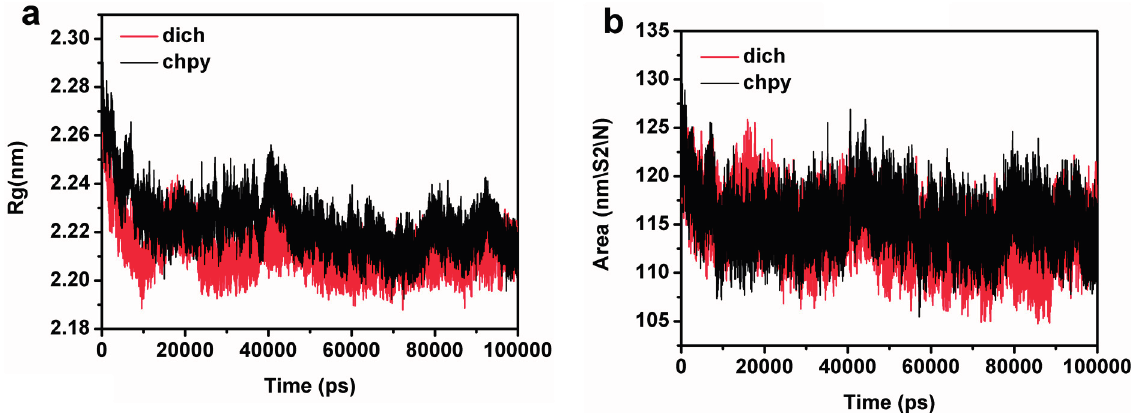
Figure 8. ( a ) Radius of gyration (Rg) for the chlorpyrifosmethyl oxon (black) and dichlorvos (red) bound to APH; and ( b ) Solvent accessible surface area for the chlorpyrifosmethyl oxon (black) and dichlorvos (red) bound to